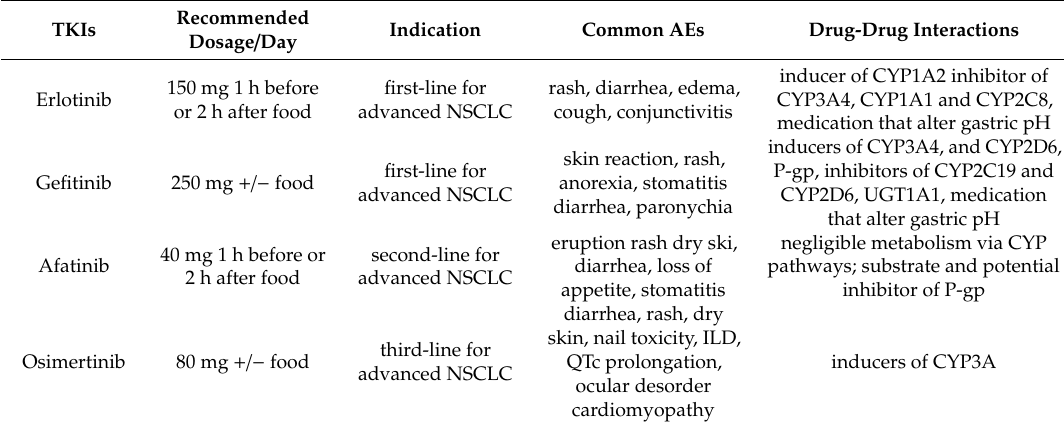
Table 2. Oral agents for treatment and significant interactions of metastatic lung